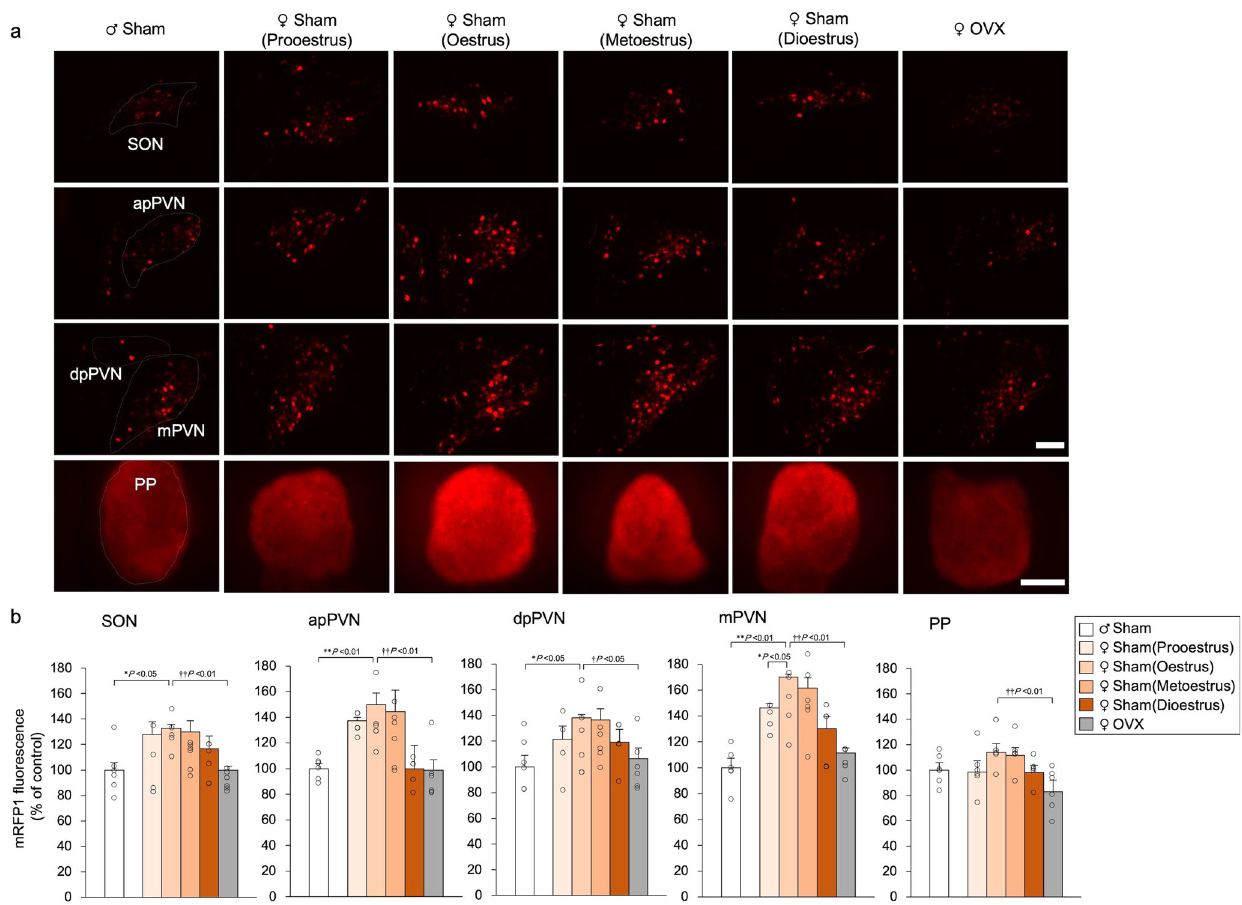
Fig. 3 Effects of OVX on OXT-mRFP1 fl uorescence. a OXT-mRFP1-positive neurons fl uoresce in the SON, apPVN, dpPVN, and mPVN of sham-operated male, sham-operated female in the pro-oestrus, oestrus, metoestrus, and dioestrus stages, and OVX female OXT-mRFP1 transgenic rats ( fi rst three rows). Scale bar indicates 100 μ m. OXT-mRFP1 fl uorescence in the PP of sham-operated male, sham-operated female in the pro-oestrus, oestrus, metoestrus, and dioestrus stages, and OVX female OXT-mRFP1 transgenic rats (last row). Scale bar indicates 500 μ m. b OXT-mRFP1 expression in the SON, apPVN, dpPVN, mPVN, and PP of the rats (male [ n = 5], pro-oestrus female [ n = 5], oestrus female [ n = 5], metoestrus female [ n = 5], dioestrus female [ n = 5], and OVX female [ n = 6]). The data are presented as the mean ± SEM (one-way ANOVA) ( ** P < 0.01, * P < 0.05, compared with male rats; †† P < 0.01, † P < 0.05, compared with oestrus and OVX female